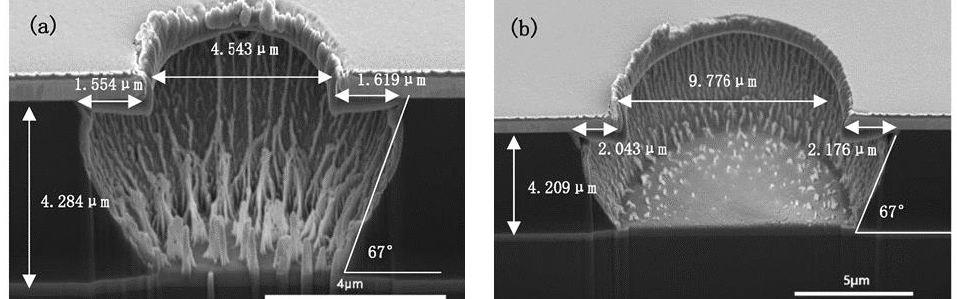
Figure 9. ICP etching of fully cured PI under 2500 W ICP power, 500 W RF power, 10% CHF 3 ratio, 100 sccm gas flow and 2 min. (( a ) the via diameter is 4 μm ; ( b ) the via diameter is 9 μm )